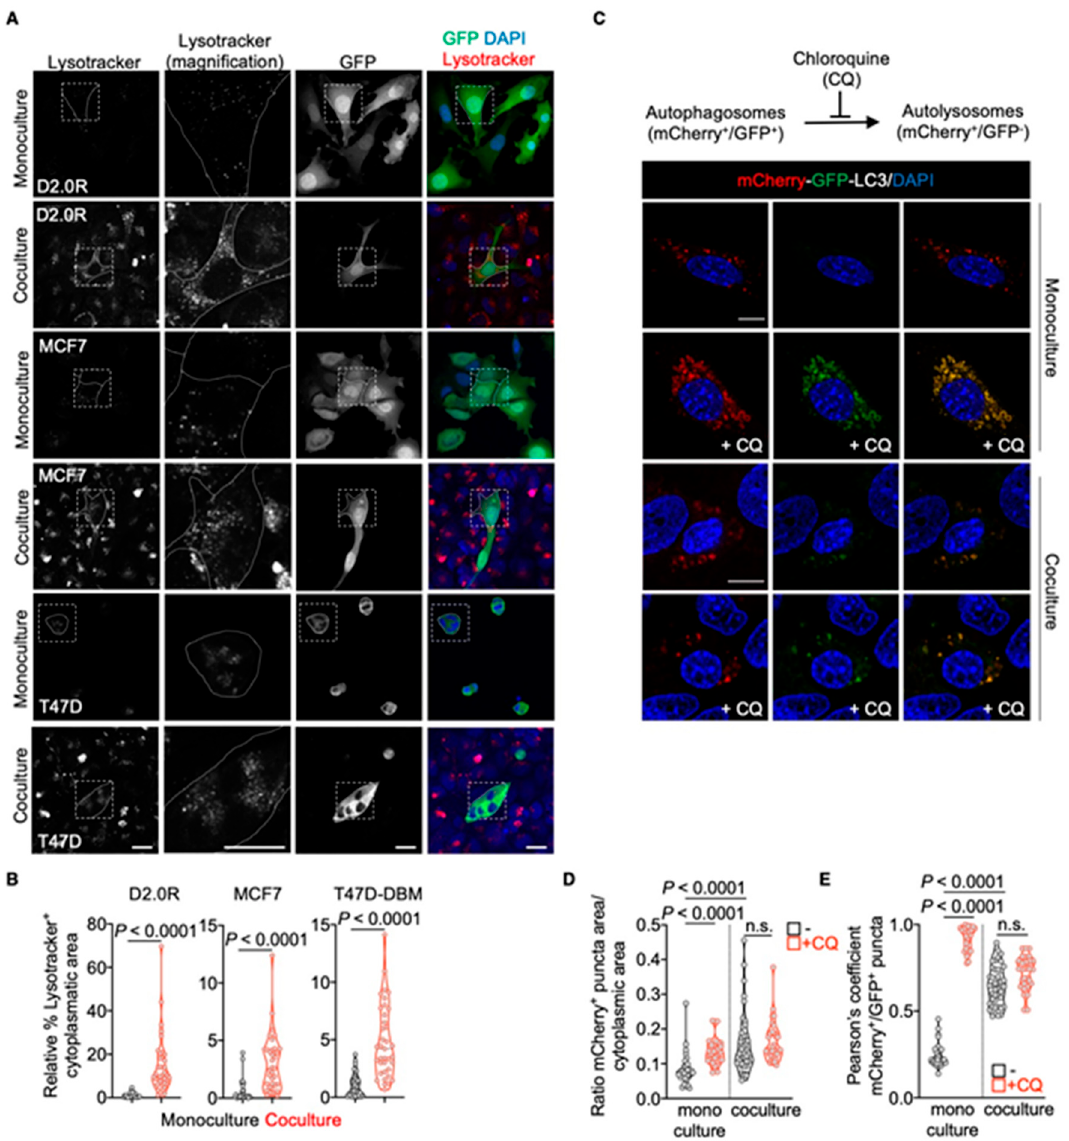
Figure 2. Accumulation of lysosomal vesicles in cocultured DDCCs. ( A ) Lysosomal accumulation in D2.0R-EGFP, MCF7- EGFP and T47D-DBM-EGFP cells upon monoculture or coculture with AT1-like cells as visualized by Lysotracker staining. Dashed box: area magnified in the middle images. Scale bar: 20 µ m. ( B ) Quantification of the relative cytoplasmic area with Lysotracker+ staining. Mann-Whitney test. n = 3 independent experiments. ( C ) Representative pictures of mCherry and GFP fluorescent signals in D2.0R cells transfected with mCherry-GFP-LC3 tandem construct upon monoculture or coculture. Scale bar: 20 µ m (monoculture), 15 µ m (coculture). ( D ) Cytoplasmic area with mCherry+ve puncta in cells showed in ( C ). Kruskal–Wallis test, multiple comparisons. n = 2 independent experiments. ( E ) Colocalization of mCherry+ve and GFP+ve signals in cells showed in ( C ) expressed with Pearson’s correlation coefficient. Kruskal–Wallis test, multiple comparisons. n = 2 independent